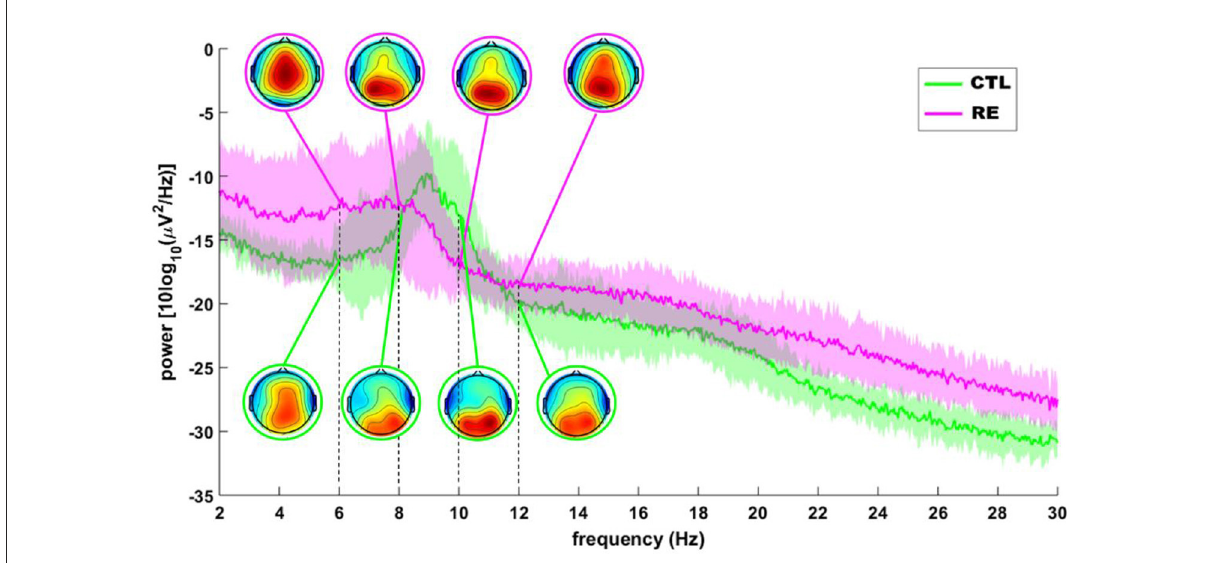
FIGURE1 Grand average of the EEG power spectrum of RE (red) and control (green) subjects. Insets depict, topographical distribution of mean alpha power. The shaded area around each line is the SD.